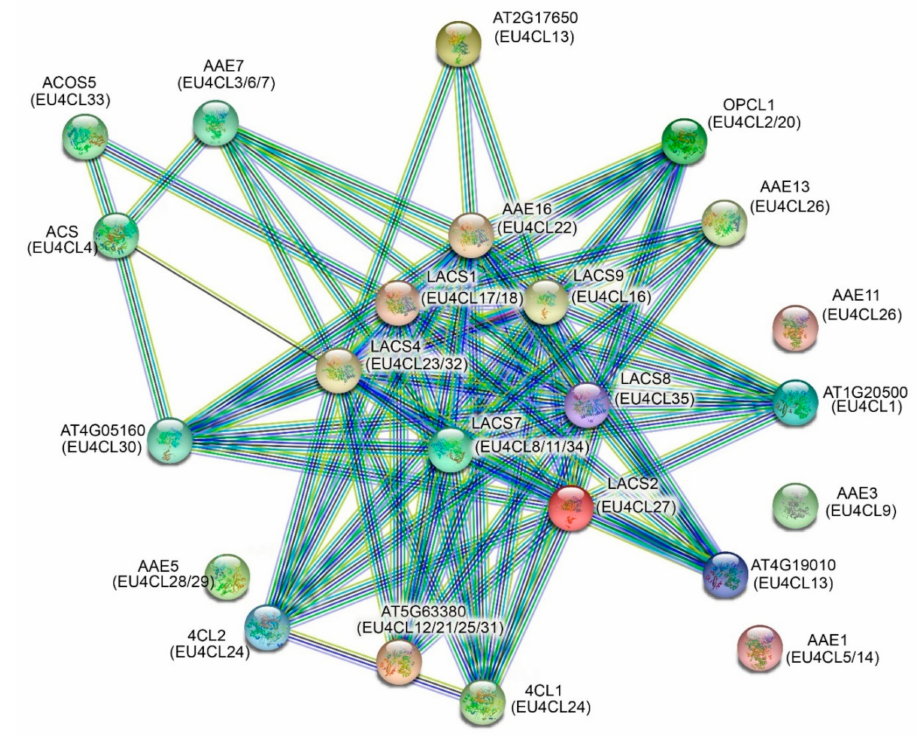
Figure 3. The predicted protein interaction network of the Eu4CL protein based on orthologs in Arabidopsis using STRING database.